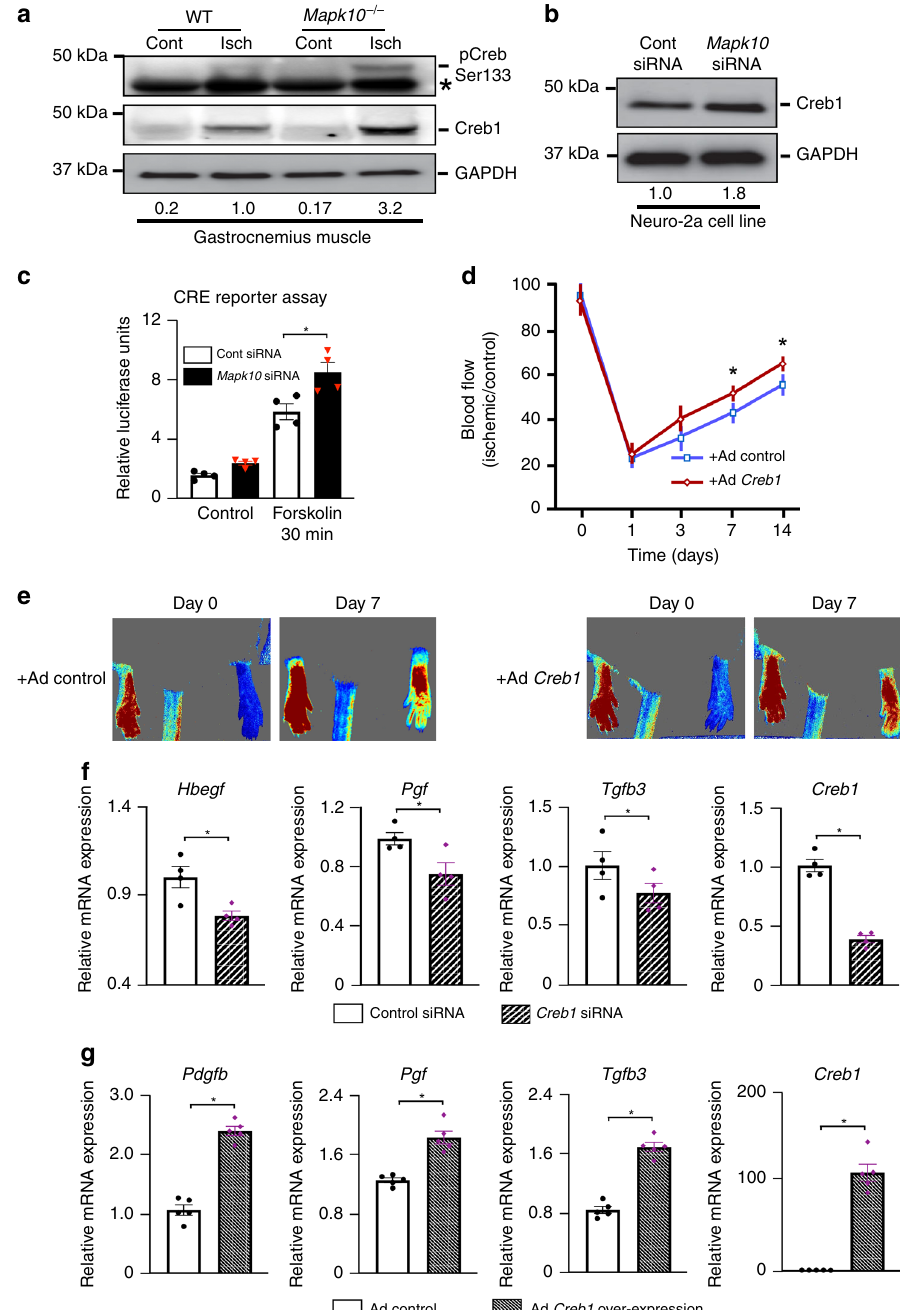
Fig. 6 Creb1 transcription factor improves the blood fl ow recovery after hindlimb ischemia. a Gastrocnemius muscle was isolated from control and ischemic legs of both WT and Mapk10 − / − mice on day 3 after femoral artery ligation and immunoblot analysis was performed with antibodies for pCreb1 (phosphor- Ser133), Creb1, and GAPDH. b Lysates prepared from N2a cells treated with control siRNA or siRNA against Mapk10 (48 h) were examined by immunoblot analysis using antibodies for Creb1 and GAPDH. c A Luciferase reporter assay for the Creb1 recombinase enzyme was performed on N2a cells treated with either control siRNA or Mapk10 siRNA (48 h) both with and without Forskolin (30 min) a Creb1 activator ( n = 4 in each group). d Control Ad-GFP and Ad- Creb1 were injected (single dose of 2 × 10 8 c.f.u.) into the gastrocnemius muscle of WT mice. Three days following the injection femoral artery ligation was performed and blood fl ow measurements by Laser Speckle Contrast Imager ( n = 7 in each group) were obtained. e Representative images of hindlimb blood fl ow of WT mice 7 days post femoral artery ligation and adenoviral (control Ad-GFP and Ad- Creb1 ) injection were measured by laser speckle contrast imaging. f RNA was prepared from control and Creb1 siRNA-treated neuro-2a cell line with hypoxia for 90 min and qRT-PCR was performed for genes indicated ( n = 4 in each group). g RNA was isolated from control and Creb1 overexpressing N2a cells and qRT-PCR was performed for growth factors related genes ( n = 5 in each group). Statistically signi fi cant differences between groups are indicated (* P < 0.05 by Student ’ s t test). The data are mean ± SEM. Source data are provided as a Source Data fi